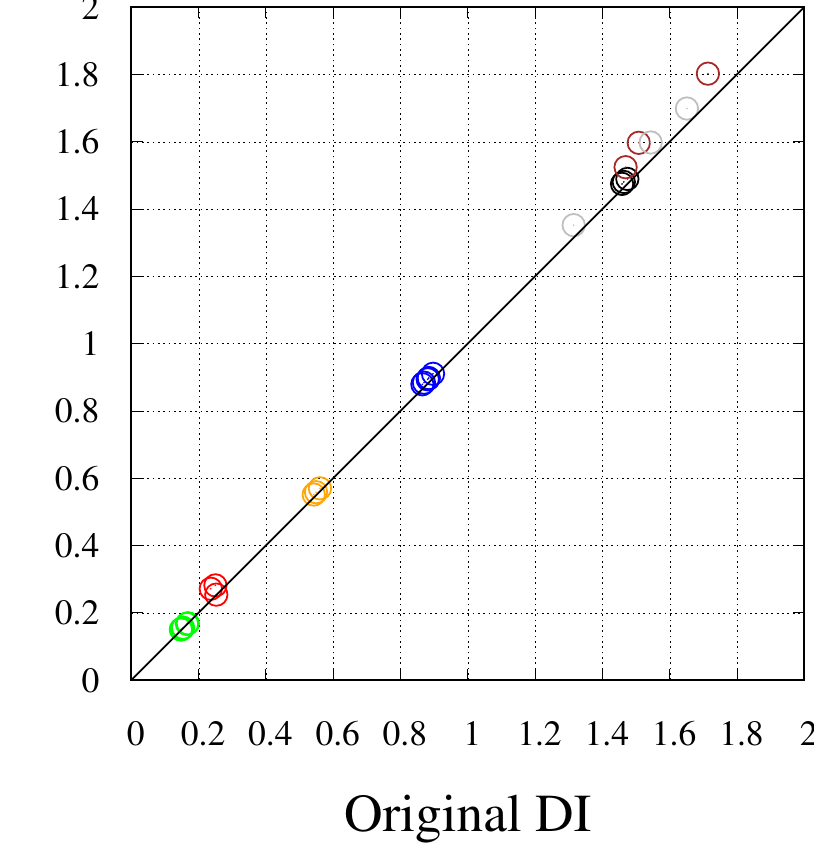
Figure 3. Comparison between DI in the monomer computed with the original ( x axis) and the new algorithm ( y axis). Different colors are used for atom pairs indicated in Figure 2: black—Pt1-Ct (pair type 1); red—Pt1-Ot (pair type 2); blue—Pt1-Cb (pair type 3); green—Pt1-Ob (pair type 4); orange—Pt1-Pt1 (pair type 5); brown—Ct-Ot (pair type 7); gray—Cb-Ob (pair type